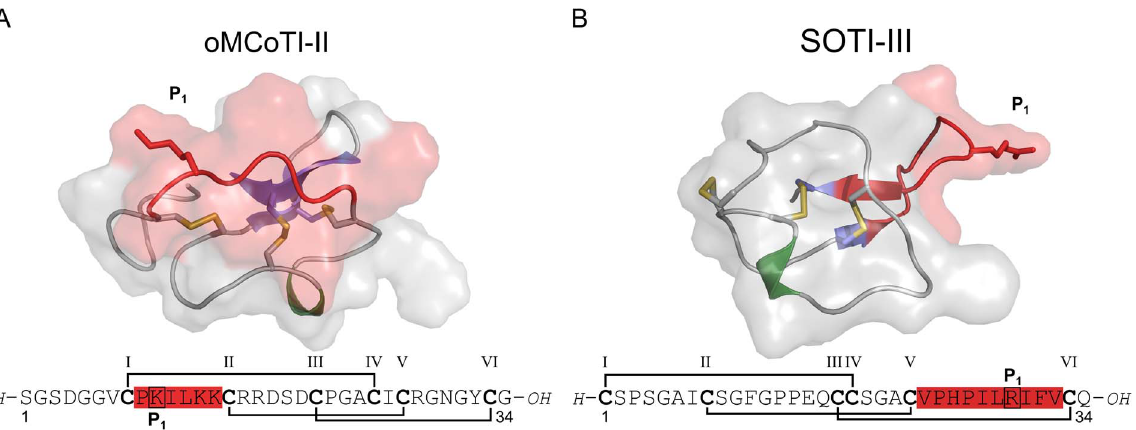
Figure 1. Sequences and structures of cystine-knot trypsin inhibitors. ( A ) Knottin oMCoTI-II (pdb: 1ha9). ( B ) SOTI-III (pdb: 4aor). Secondary structure is shown as cartoon with surface, and cysteine residues are depicted as yellow sticks; protease-binding regions (or inhibitor loops) are depicted in red, b -sheets - in blue, and a -helices - in green. Cystine-forming residues are marked bold, and the numbering of respective cysteines is according to their appearance in the sequence.